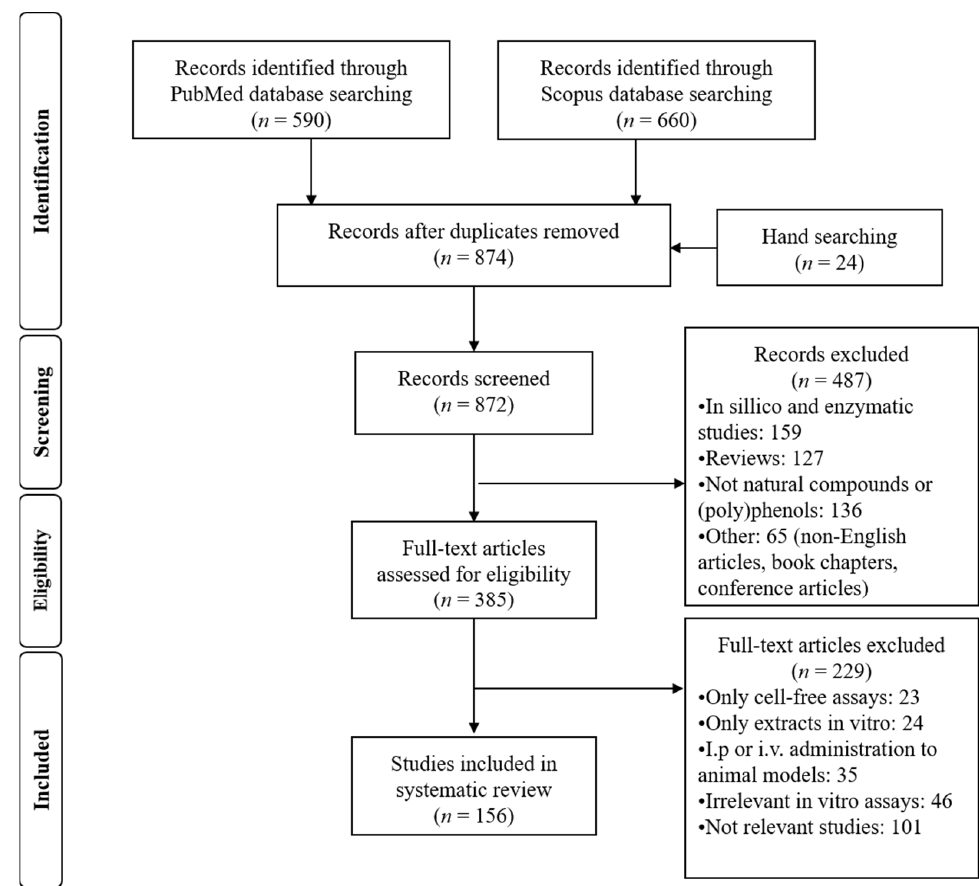
Figure 6. PRISMA flow diagram. Description of the search strategy and exclusion/inclusion criteria.